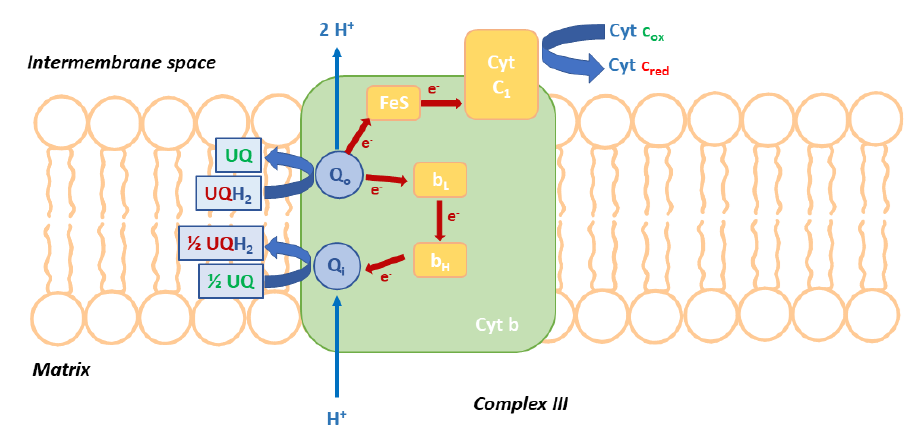
Figure 1. Schematic model of cytochrome bc1 complex. The homodimeric bc1 complex presents three catalytic subunits: cytochrome b (cyt b) with two b-type haems (b H and b L ), the Rieske iron–sulfur protein (FeS) and cytochrome c1 (cyt c1) with one c-type haem. The two binding sites for inhibitors and ubiquinone (UQ), Qi and Qo, are shown. The bifurcated electron transfer pathway from the Qo site is shown by red arrows.